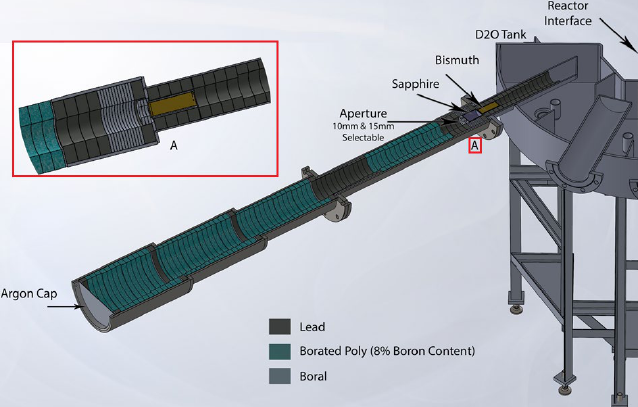
Fig. 2. Collimator components of the RSEC – NIF beam port. Note: Both, the Bismuth and Sapphire filters can be removed and placed to the beam port depending on the neutron spectrum needs.